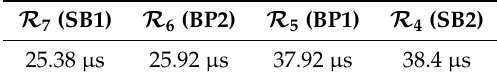
Table 7. Maximum response times obtained by